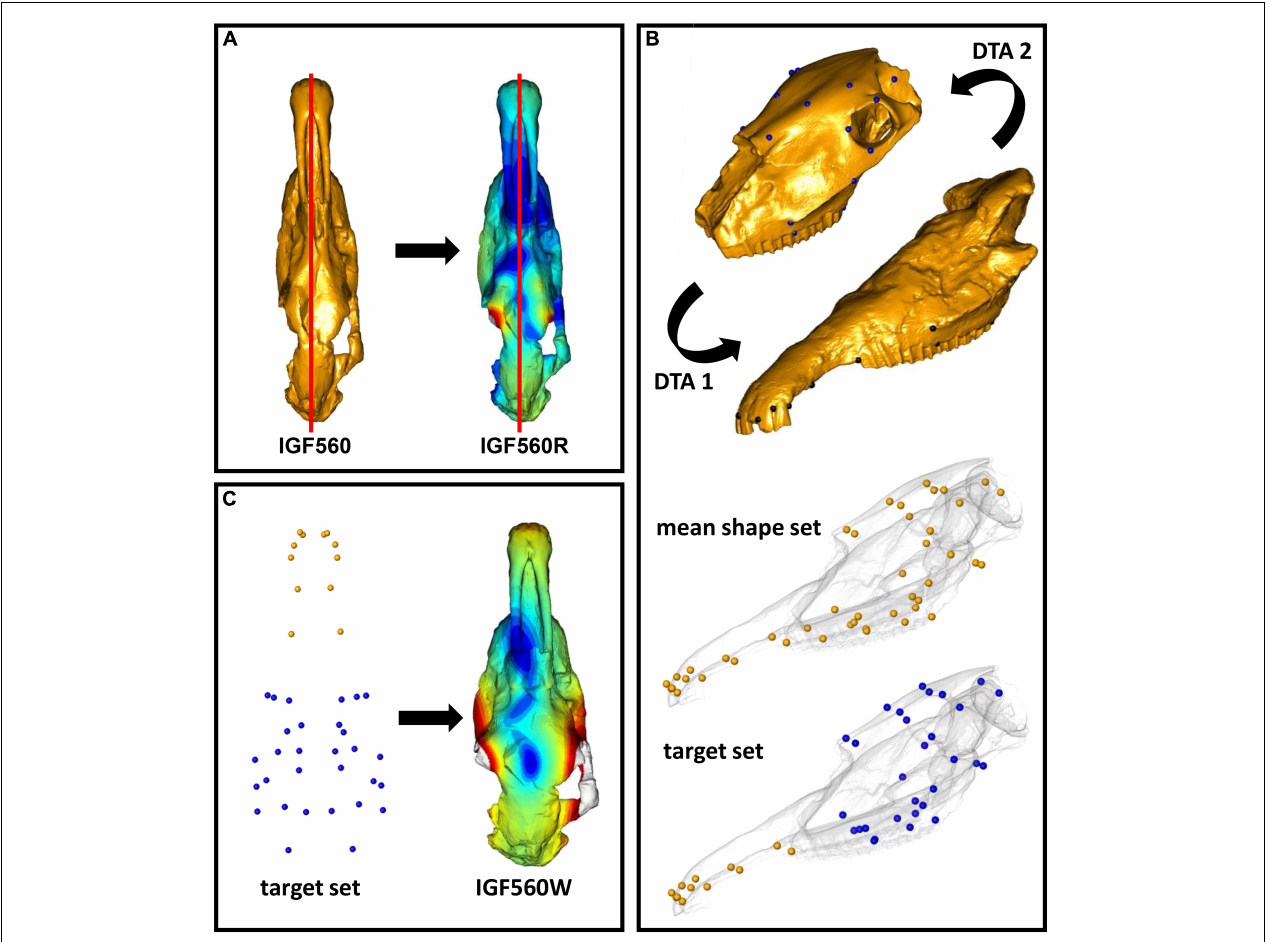
FIGURE 5 | Fossil restoration process explained step by step. (A) The IGF560 specimen is symmetrized by using retroDeformMesh() to obtain IGF560R. (B) IGF11023 is first oriented on Dm5 (DTA 1), then Dm5 is oriented on IGF11023 (DTA 2). A mean shape between the first aligned set and the second is computed. The target set is built by using the Dm5 landmark set and the landmarks of the mean shape set belonging to the snout. (C) IGF560R is warped via thin plate spline transformation based on the target